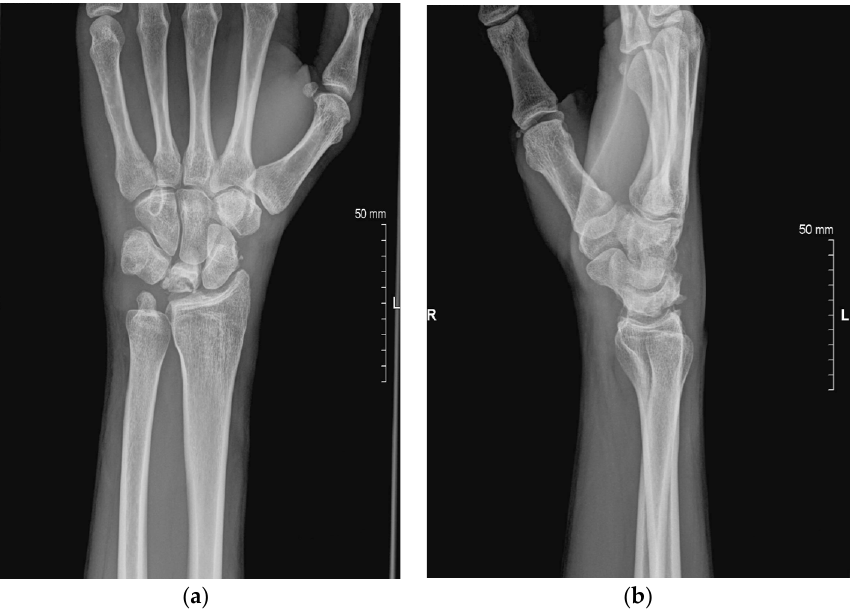
Figure 2. X-ray stage 3A: the collapse of lunate, carpal high preserved. ( a ) Stage 3A, AP view X-ray; ( b ) Stage 3A, lateral view X-ray.